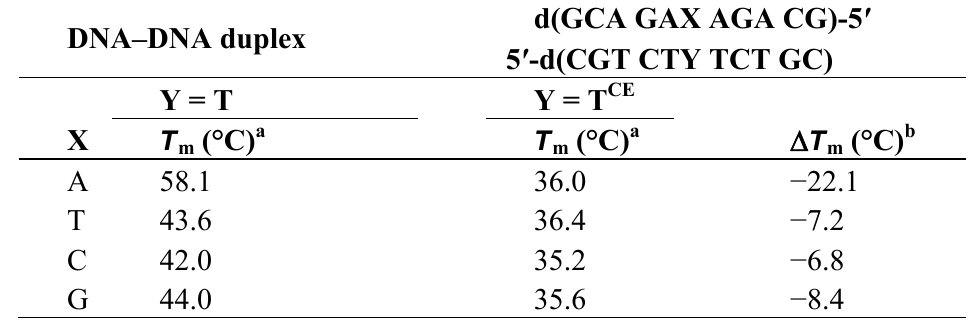
Table 3. T values for DNA–DNA 11-mer duplexes containing T CE m